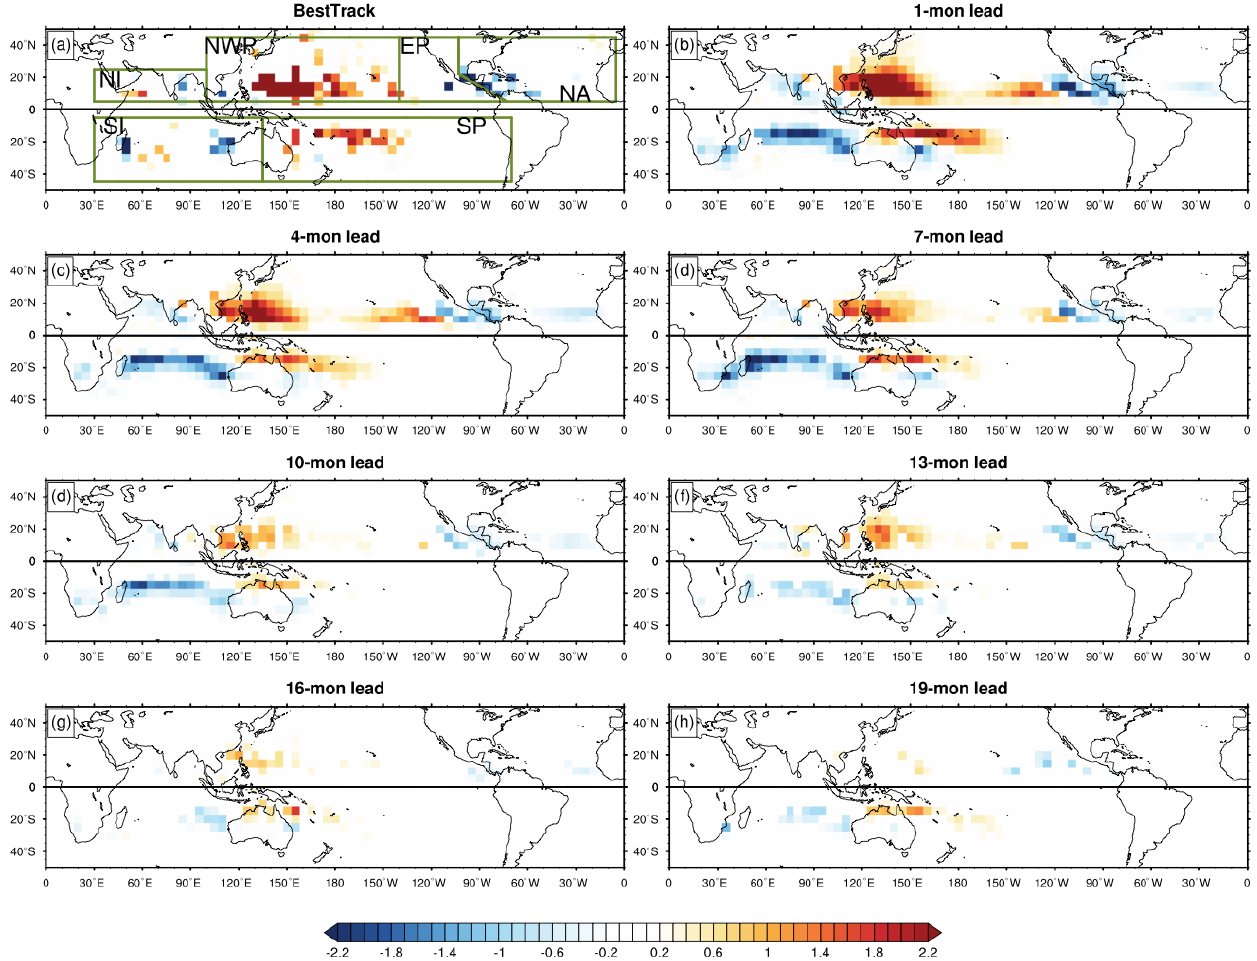
Figure 14. Regressions of seasonal-mean TC track density on the corresponding seasonal mean Niño-3.4 index (JJASON in the Northern Hemisphere and DJFMAM in the Southern Hemisphere) for the period of 1971–2018 in the (a) Best Track observations and (b–h) SMYLE forecasts. Shadings are significant at the 90% confidence level. The green lines in panel (a) mark the boundaries of different TC basins – northwestern Pacific (NWP), North Atlantic (NA), eastern Pacific (EP), north Indian Ocean (NI), south Indian Ocean (SI), and South Pacific Ocean (SP). Note that at 19-month lead time (panel h ), data from SMYLE-NOV are for JJASO (instead of JJASON) given the 24-month simulation length. Similarly, data from SMYLE-MAY at 19-month lead are for DJFMA (instead of